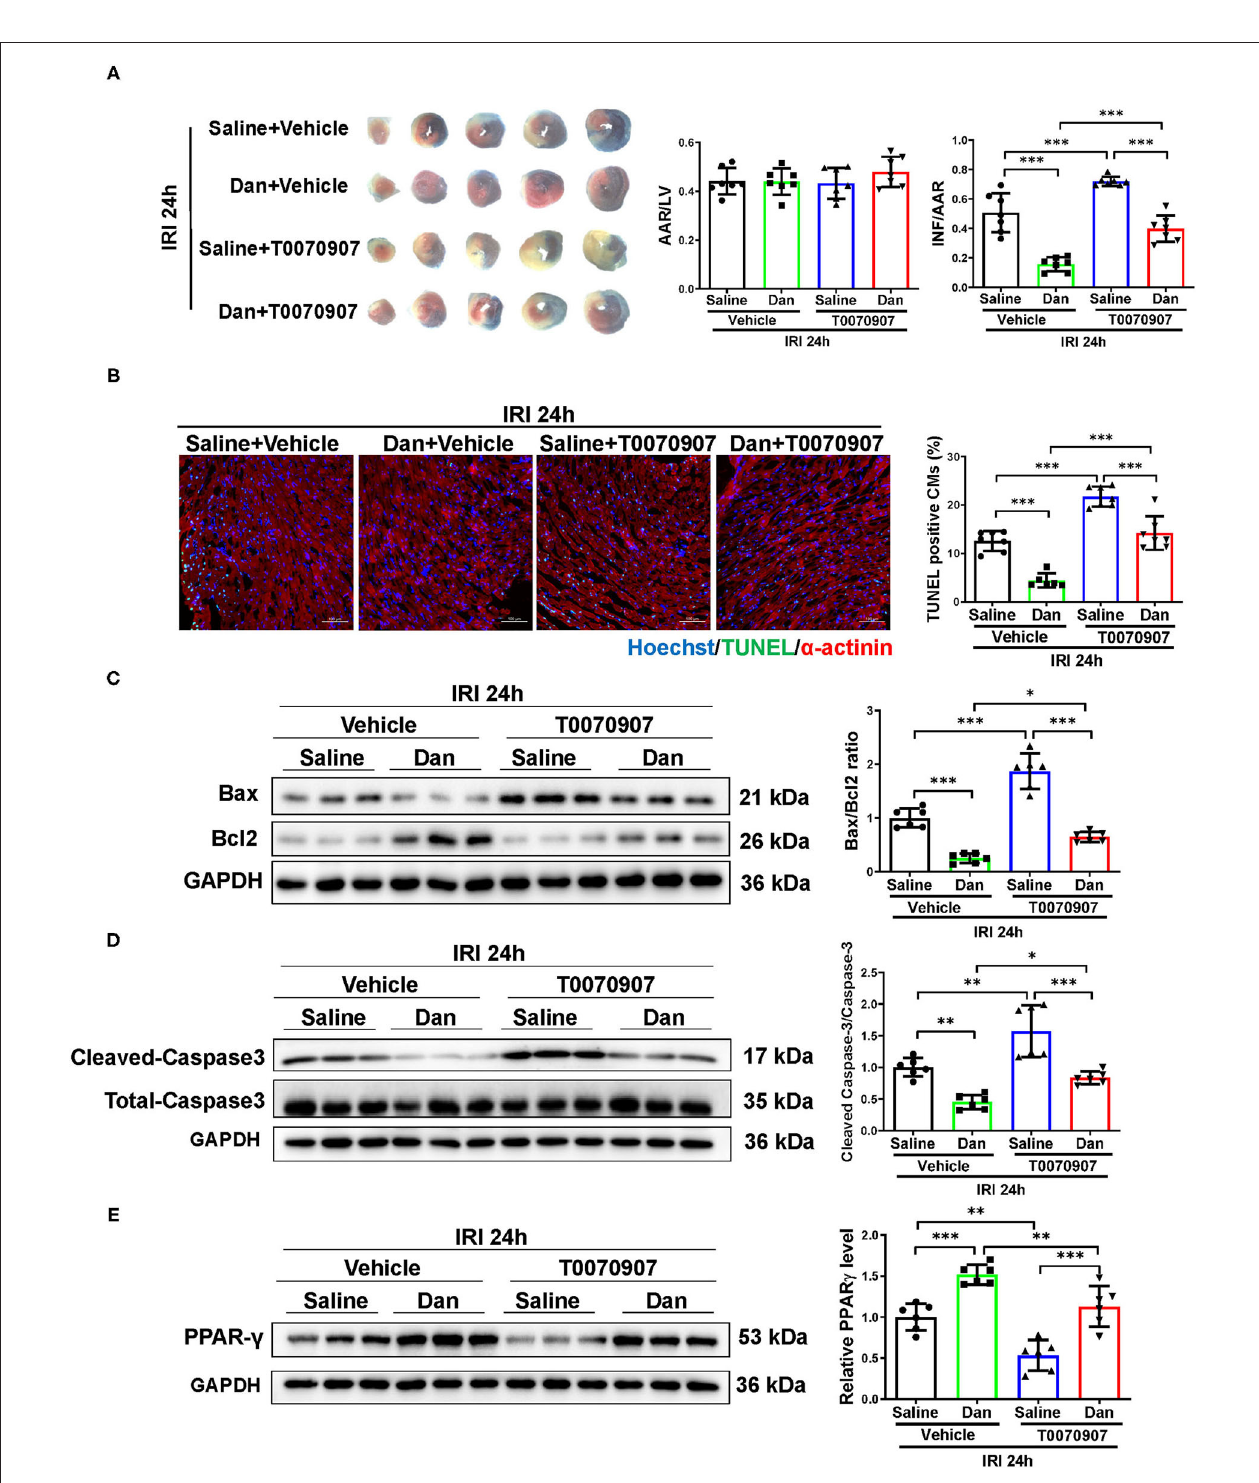
FIGURE 4 | Inhibition of PPAR γ attenuates Dan-induced cardioprotection in acute myocardial ischemia-reperfusion injury in vivo . (A) Adult male mice were intraperitoneally injected with T0070907 (1 mg/kg/day) or vehicle controls and administrated by gavage with 700 mg/kg/d of Dan for 2 consecutive weeks followed by myocardial ischemia-reperfusion injury (IRI) modeling for 24h. TTC staining was performed at 24h after IRI. The ratio of AAR/LV was determined for the homogeneity of modeling, and the ratio of infarct area/area at risk (INF/AAR) was determined for the infarct size ( n = 7). (B) Representative images and quantification results of TUNEL/ α -actinin staining were shown for myocardial apoptosis of mice ( n = 6–7). Scale bar = 100 µ m. (C,D) Western blot analysis for apoptotic-associated proteins in heart tissues, including Bax and Bcl2 (C) and cleaved-caspase 3 and total caspase 3 (D) ( n = 6). (E) Western blot for PPAR γ in mice IRI heart tissues administrated with T0070907 or vehicle in the presence or absence of Dan treatment ( n = 6). * p < 0.05; ** p < 0.01; *** p < 0.001.